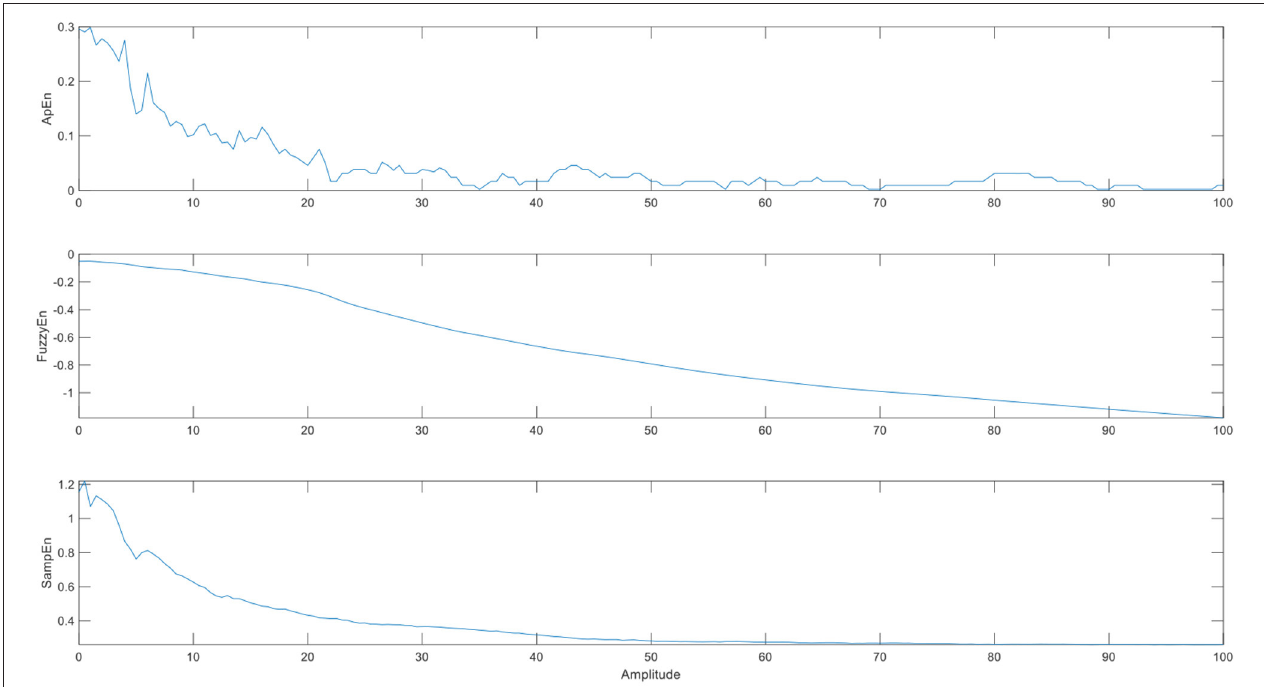
FIGURE 4 | The brain entropy adding different amplitudes of sine waves to a voxel time series of cerebrospinal fluid. (The abscissa is the amplitude of the sine wave, and its value is a multiple of the maximum noise).